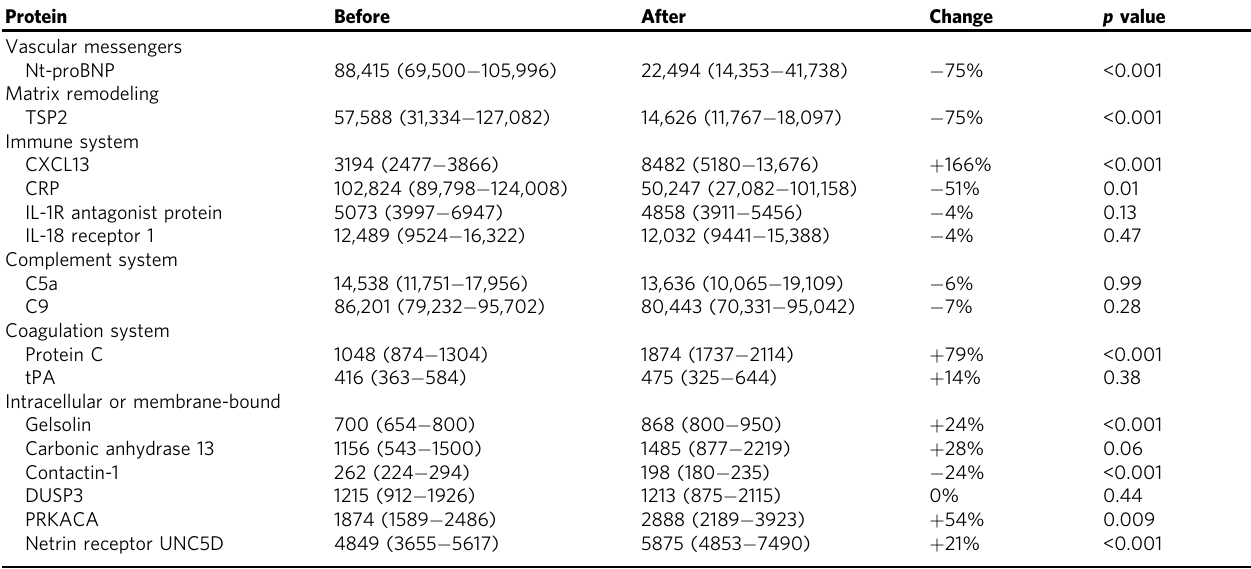
Table 3 Dynamics of proteins for heart failure development before and 6 months after heart transplantation. Protein Before After Vascular messengers